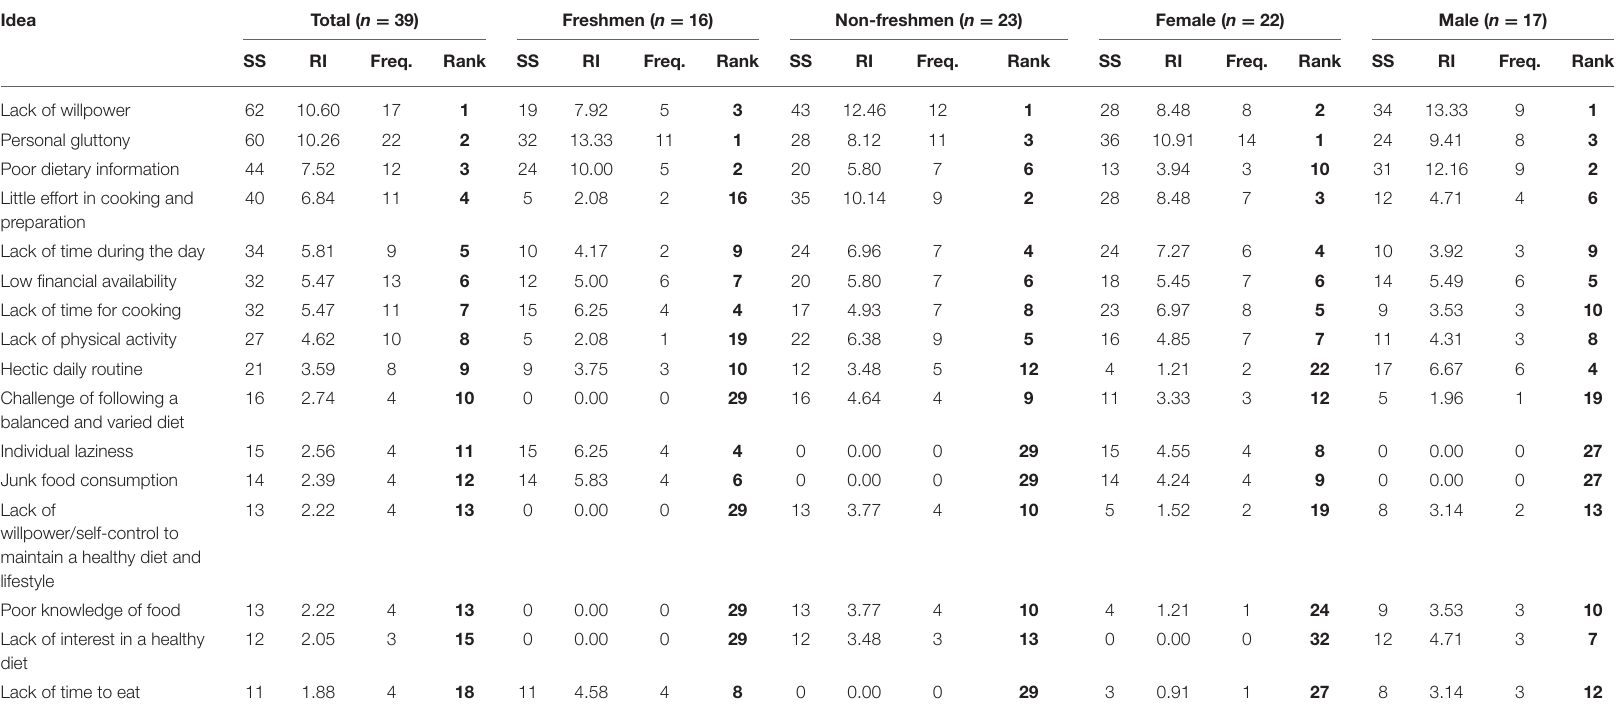
TABLE 3 | Aggregated results across the 7 groups on personal barriers to maintaining a healthy